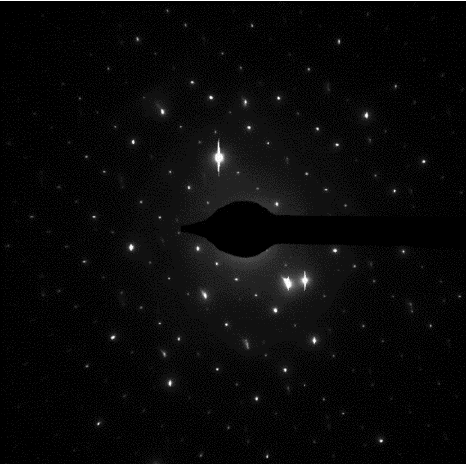
Figure 8. The diffraction pattern of an electron beam passing through β -Ga 2 O 3 nanowire. The pattern reveals a monocrystalline structure of the nanowire.